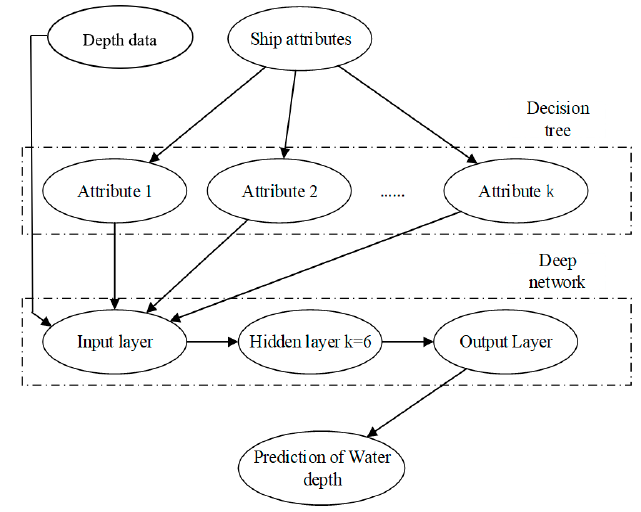
Figure 3. The structure of the hybrid DDTree model. Ship attributes are taken from AIS. Depth data for DDTree model input are taken from Global Mapper.